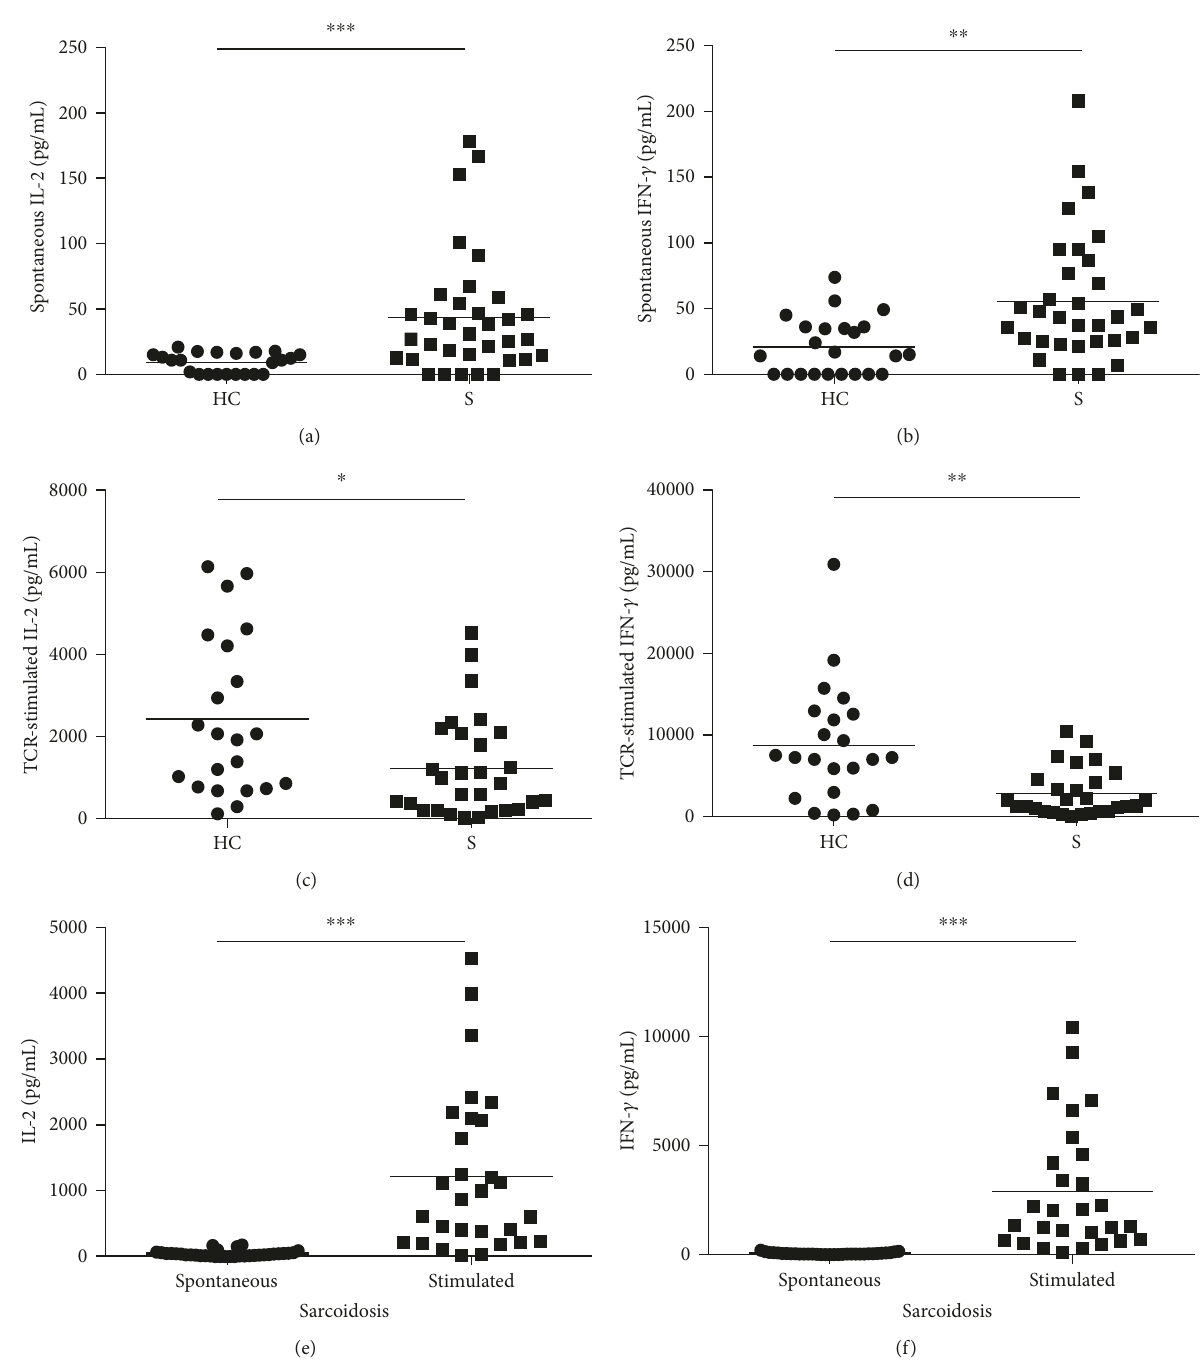
Figure 1: Spontaneous and TCR-stimulated cytokine secretion in CD4 + T cells. CD4 + T cells were isolated from the PBMC of healthy control (HC) or sarcoidosis (S) subjects and cultured for 24 hours in the absence (a and b) or presence (c and d) of polyclonal TCR stimulation. Cell culture supernatants were collected 24 hours post TCR stimulation and analyzed for cytokine secretion by cytokine bead array. (a) Spontaneous IL-2 secretion in pg/mL. (b) Spontaneous IFN- γ secretion in pg/mL. (c) TCR-stimulated IL-2 secretion in pg/mL. (d) TCR-stimulated IFN- γ secretion in pg/mL. (e) Spontaneous and TCR-stimulated IL-2 secretion by sarcoidosis CD4 + T cells in pg/mL. (f) Spontaneous and TCR-stimulated IFN- γ secretion by sarcoidosis CD4 + T cells in pg/mL. Horizontal lines represent mean values of cytokine secretion for each cohort. Statistical analysis was performed using the Mann – Whitney U test. ∗ p < 0 05 , ∗∗ p < 0 01 , and ∗∗∗ p < 0 001